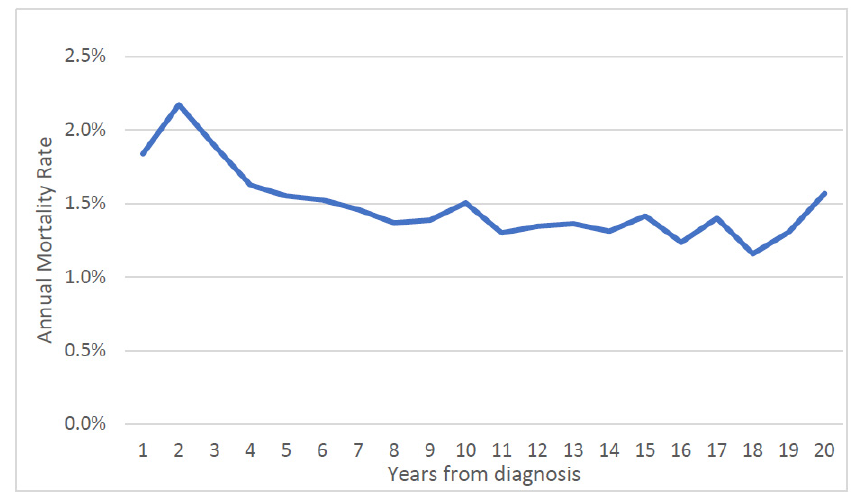
Figure 1. Annual prostate specific mortality rate by time from diagnosis (entire cohort).